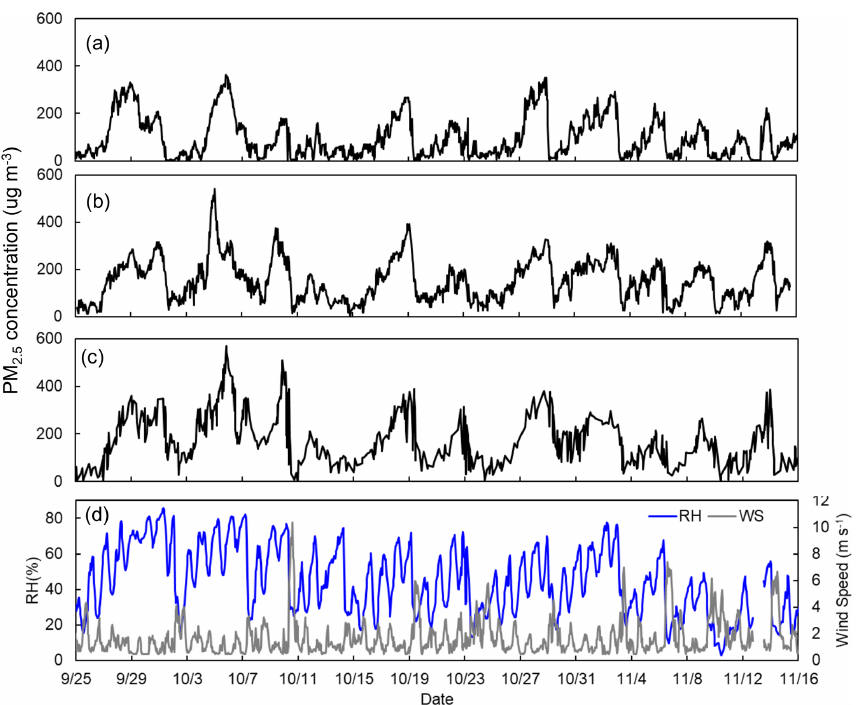
Figure 1. Time series of PM 2 . 5 mass concentration measured at three megacities over the North China Plain (NCP), including (a) Beijing, (b) Baoding, and (c) Shijiazhuang from 25 September to 16 November 2013, and (d) the associated relative humidity (RH, blue line) and 10m wind speed (grey line) in Beijing. The PM 2 . 5 mass concentration and meteorological fields in Beijing are taken from Guo et al. (2014), and the PM 2 . 5 data for Baoding and Shijiazhuang are taken from https://air.cnemc.cn:18007/ (last access: 12 January 2021). Two severe haze episodes from 25–29 September and from 2–7 October are selected as the case studies in this work, and the two vertical dash lines label the time for the peak PM 2 . 5 concentration in